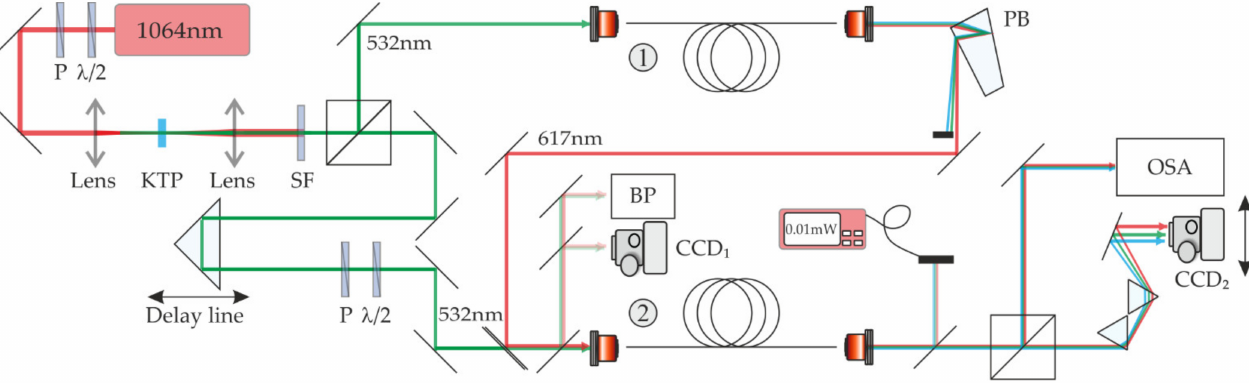
Figure 3. The experimental setup for investigation of the self-seeded IM-FWM process: P—polarizer, λ /2—half-wave plate, KTP—nonlinear crystal, SF—short pass filter, FUT—fiber under test, BP—beam profiler, PM—power meter, CCD—digital camera, OSA—optical spectrum analyzer, PB—Pellin– Broca